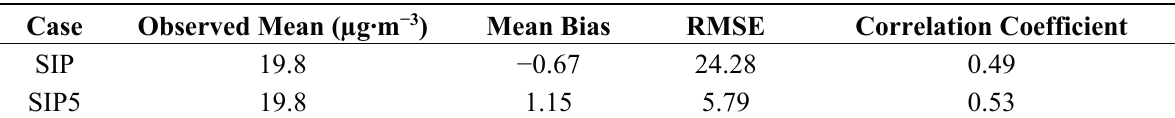
Table 3. Statistical metrics based on 36 hourly reporting PM 2.5 monitors for Base and SIP5